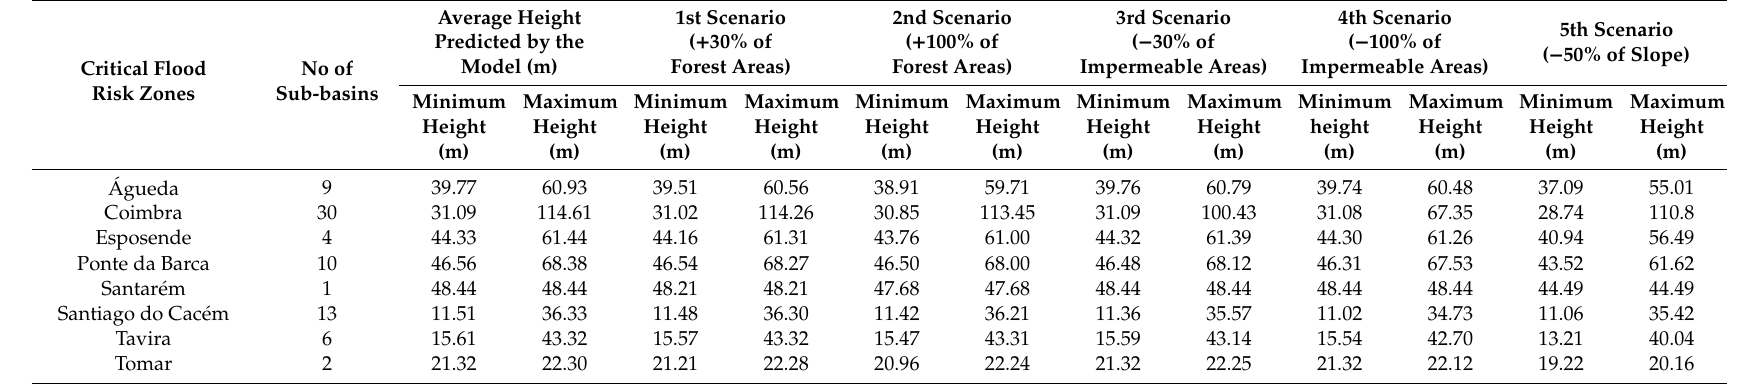
Table 4. Results of scenario analysis in the 75 sub-basins of the eight critical flood risk